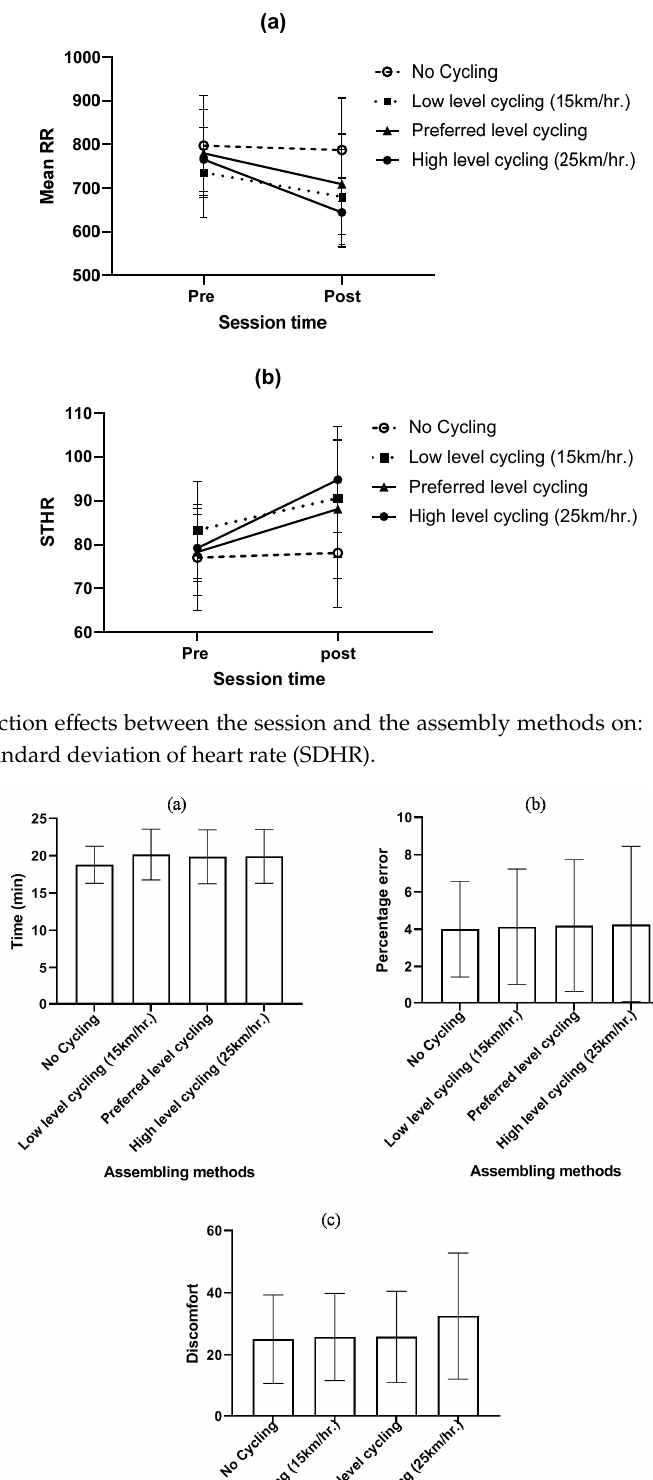
Figure 5. Mean ( a ) time, ( b ) percentage error, and ( c ) discomfort during cycling